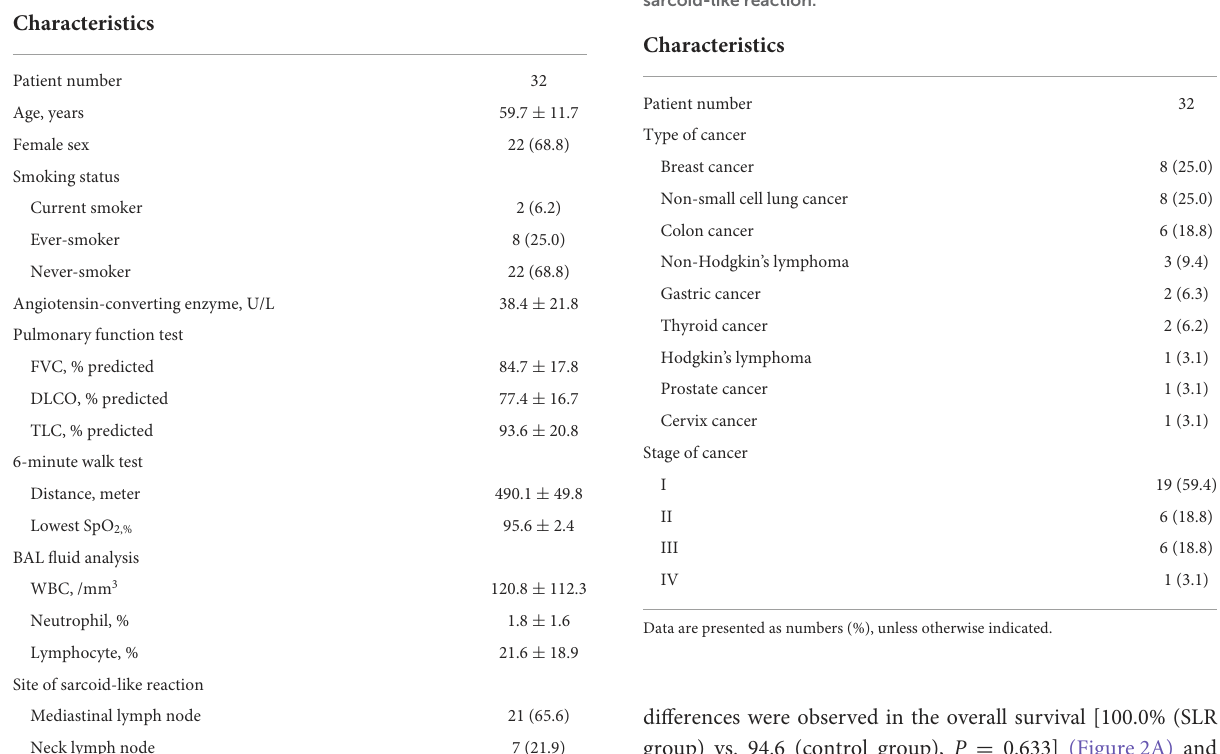
TABLE 1 Baseline characteristics of the study population. TABLE 2 Types and stage of the malignancy in patients with sarcoid-like